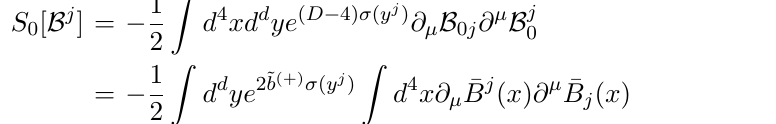
Figure 4 . Comparative plot of solutions c (+) localization condition | L.C. (red